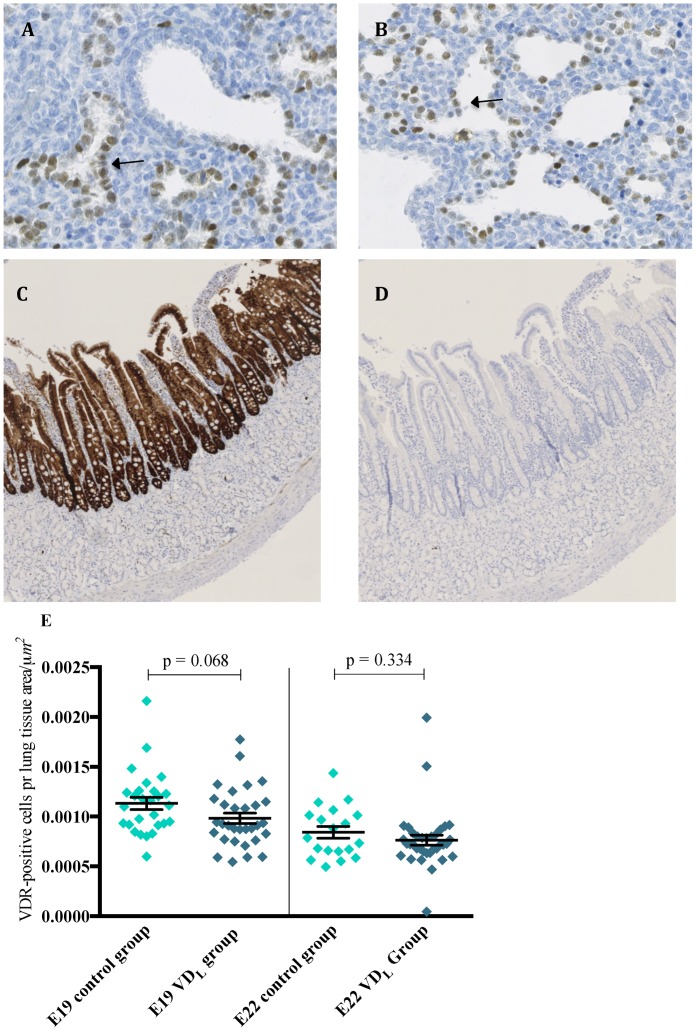
Immunohistochemical analysis of VDR in fetal rat lung.Immunohistochemistry was performed on lung tissues from each dietary group at both E19 (VDL group (n = 31); control group (n = 27)) and E22 (VDL group (n = 35); control group (n = 19)) using the monoclonal D-6 antibody and counterstained with Mayer’s hematoxylin. Representative images of lung tissue from E19 (A) and E22 (B) (Magnification x28). Arrows indicate positive ATII cells. Positive (C) and negative (D) control sections with omission of the monoclonal D-6 antibody in the duodenum (Magnification x5). The expression of VDR in the lung was evaluated as the density of positive ATII cells (cells/μm2) (E).